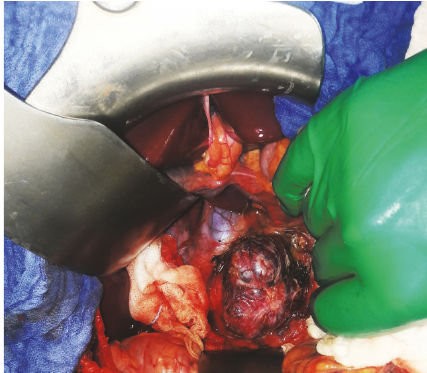
Figure 3: Surgical site showing the presence of the paraganglioma withintimatecontactwiththeabdominalaortaandtheinferiorvena cava after mobilization of the duodenum.